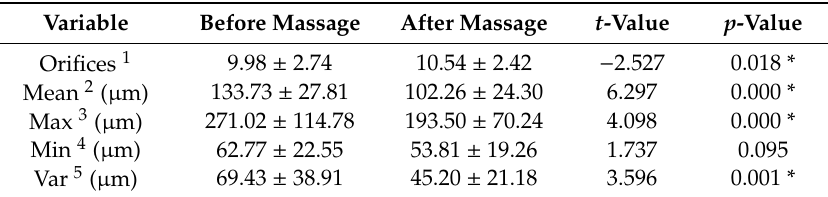
Table 2. Changes in the meibomian gland openings in patients with meibomian gland dysfunction (MGD) before and after meibomian gland